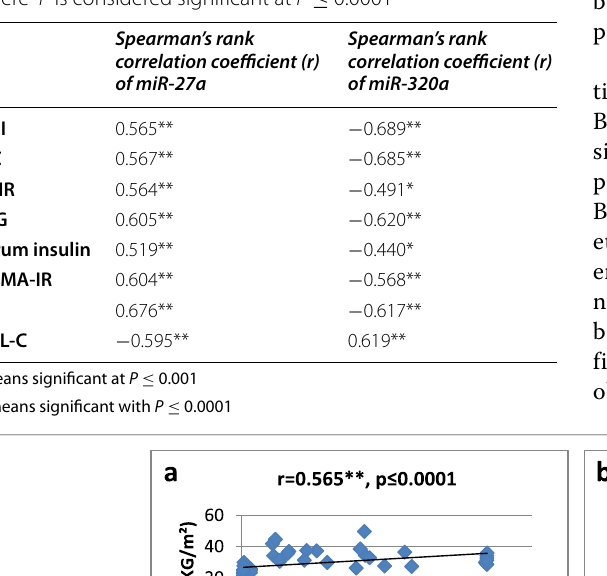
Table 3 Spearman’s rank correlation coefficient ( r ) of microRNA 27‑a and microRNA 320‑a with established clinical variables where “ r ” is considered significant at P